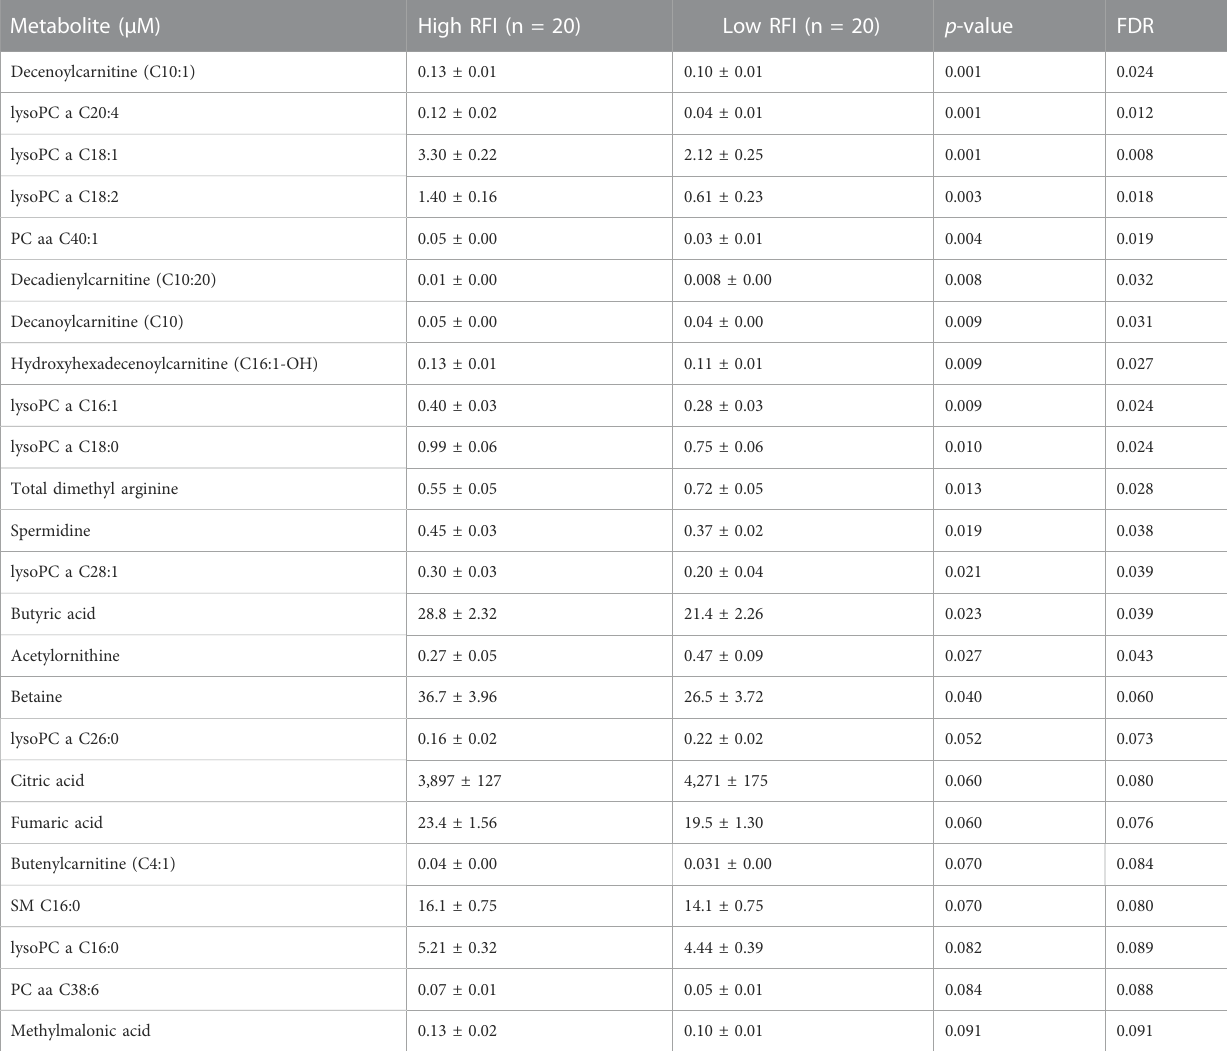
TABLE 2 List of milk metabolites with altered concentrations in the high vs. low RFI comparisons at early lactation stage. The metabolite concentrations were described in least square means (LSM) and corresponding standard error of mean (SEM) in each group with p -values and false discovery rate (FDR). Metabolite (µM)